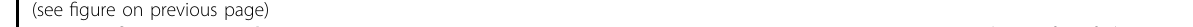
Fig. 6 TGF β 1 activation induces tumor microenvironment (TME) reprogramming in c-Myc murine HCCs. a Upregulation of TGF β downstream target genes related to TME reprogramming in EGFP or TGF β 1 activated liver tumors. Student t test was applied for statistical analysis. b, c Upregulation of TGF β downstream target genes related to TME in EGFP or TGF β 1 activated b HCC3-4 cell lines and c HCC4-4 cell lines. Student t test was applied for statistical analysis. d Quantitative RT-PCR results showing downregulation of Pmepa1 in TGF β 1 activated HCC3-4 and HCC4-4 cell lines after si Pmepa1 transfection ( N = 6 replicates in each group). Student t test was applied for statistical analysis. e, f Representative images and quanti fi cation of cell healing assay at 0-hour (0 h) and after 48 hours (48 h) treatment following TGF β 1 overexpression as well as scrambled siRNA (siSC) or si Pmepa1 transfection. Student t -test was applied for statistical analysis. P -values were as shown. Experiments were conducted three times. g, h Representative images and quanti fi cation of transwell assay 48 h after treatment following TGF β 1 overexpression as well as scrambled siRNA (siSC) or si Pmepa1 transfection. Student t- test was applied for statistical analysis. P- values were as shown. Experiments were conducted three